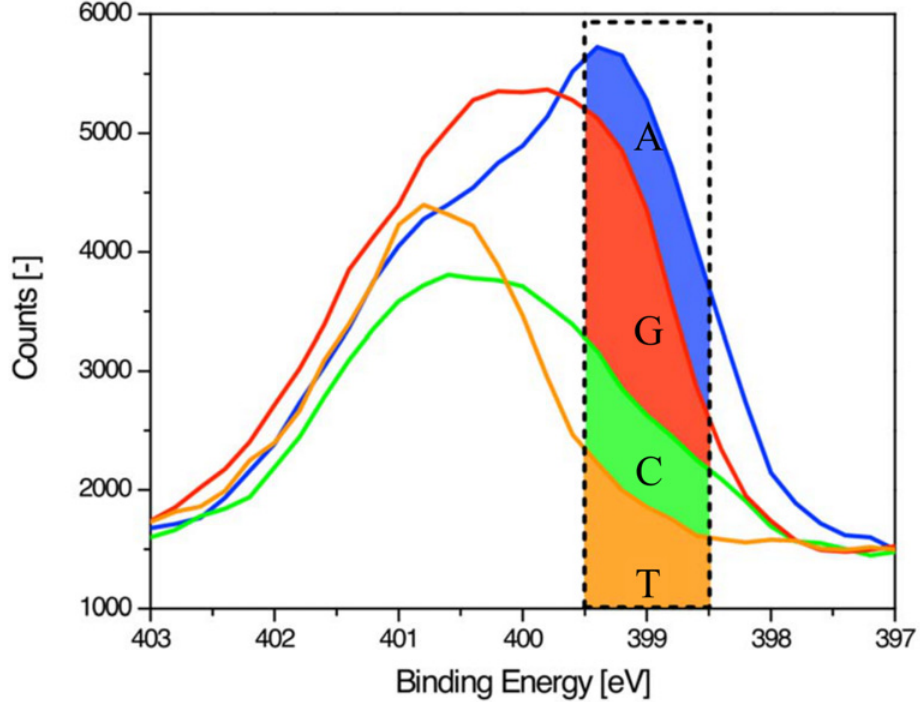
Fig 8. High-resolution nitrogen 1s XPS spectra for single-stranded homopolymeric 20mers. The dashed window centered at 399 eV highlights the difference in the amount of conjugated nitrogen between the various